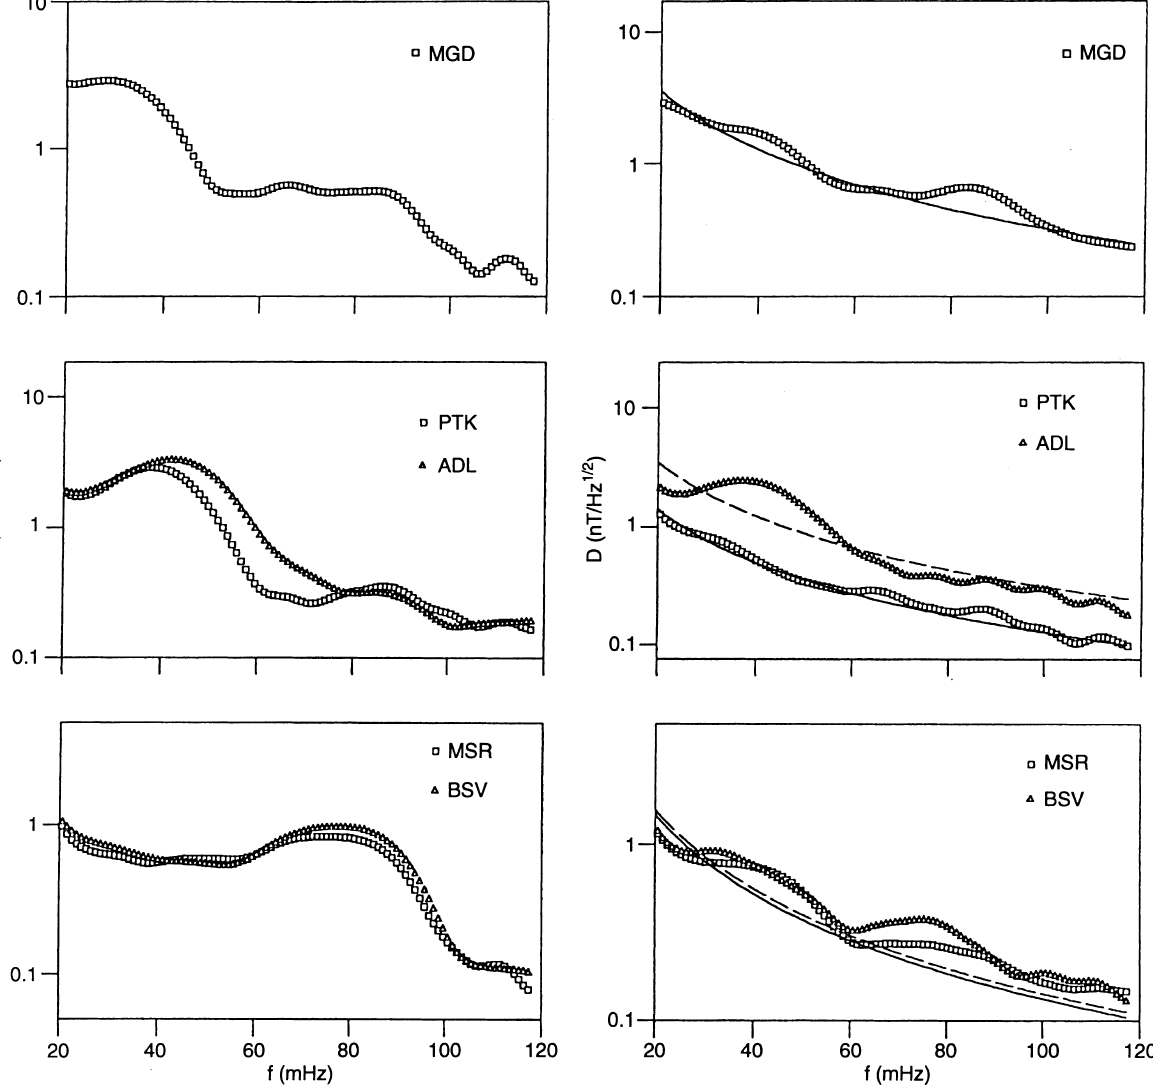
Fig. 2. Amplitude spectral densities for the interval 02:58–03:08 UT (event 1) of H -component ( left panel ) and of D -component ( right panel ). Spectral amplitudes are indicated by symbols , power best fit are shown by solid and dashed